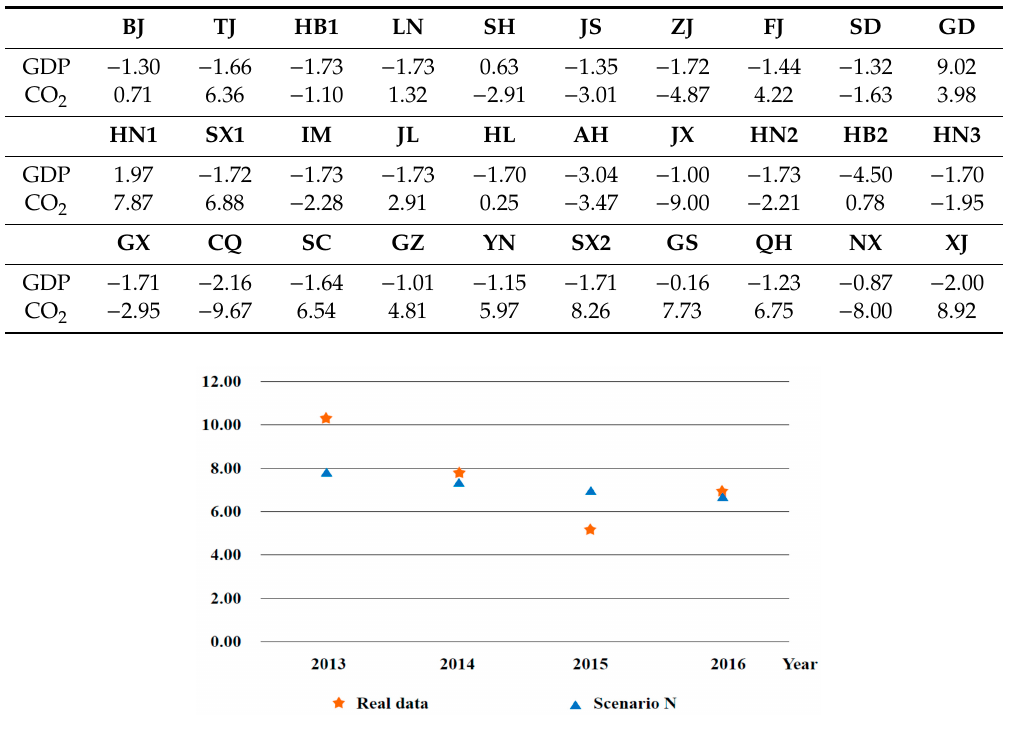
Figure 3. Comparison between real data and simulation data of scenario N in regards to GDP growth rate (shown as percentages).